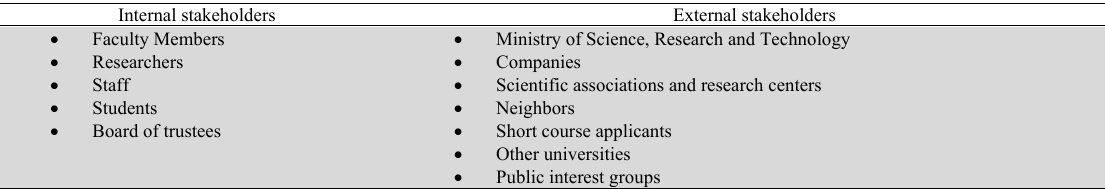
The stakeholders of the University under study